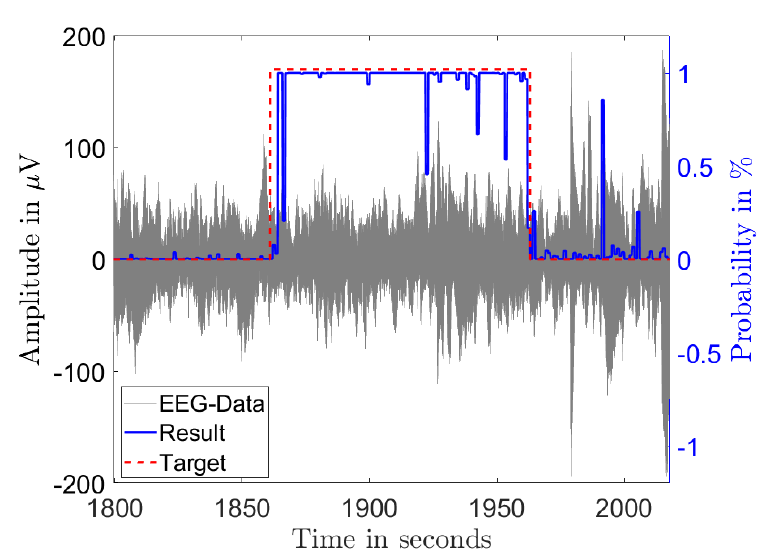
Figure 3. Single channel EEG data (gray) from a seizure record file of patient 1 showing 101 s of diagnosed seizure (red) with the output probability of the classification (blue).